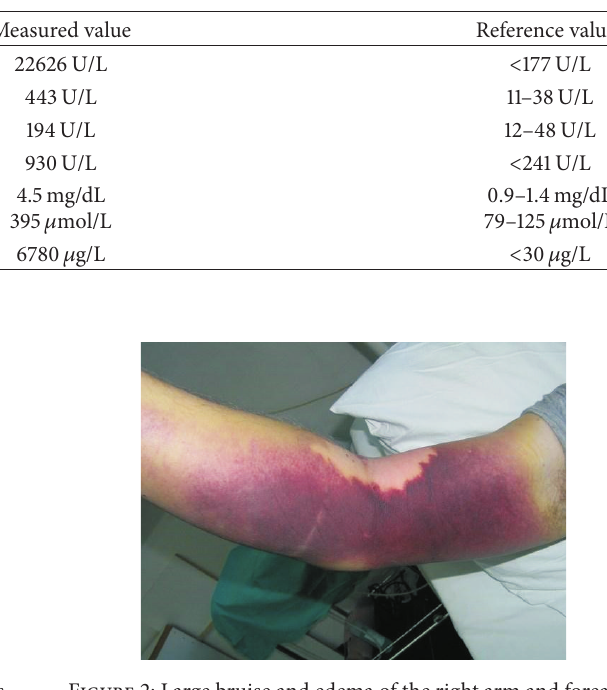
Figure 1: Hemorrhagic and nonhemorrhagic bullae, hematomas, and edema of the left palm.